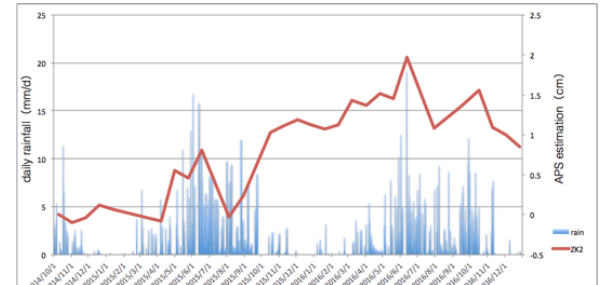
Figure 5. The relationship of rainfall and accumulative atmospheric phase corrections achieved by time series processing on Borehole